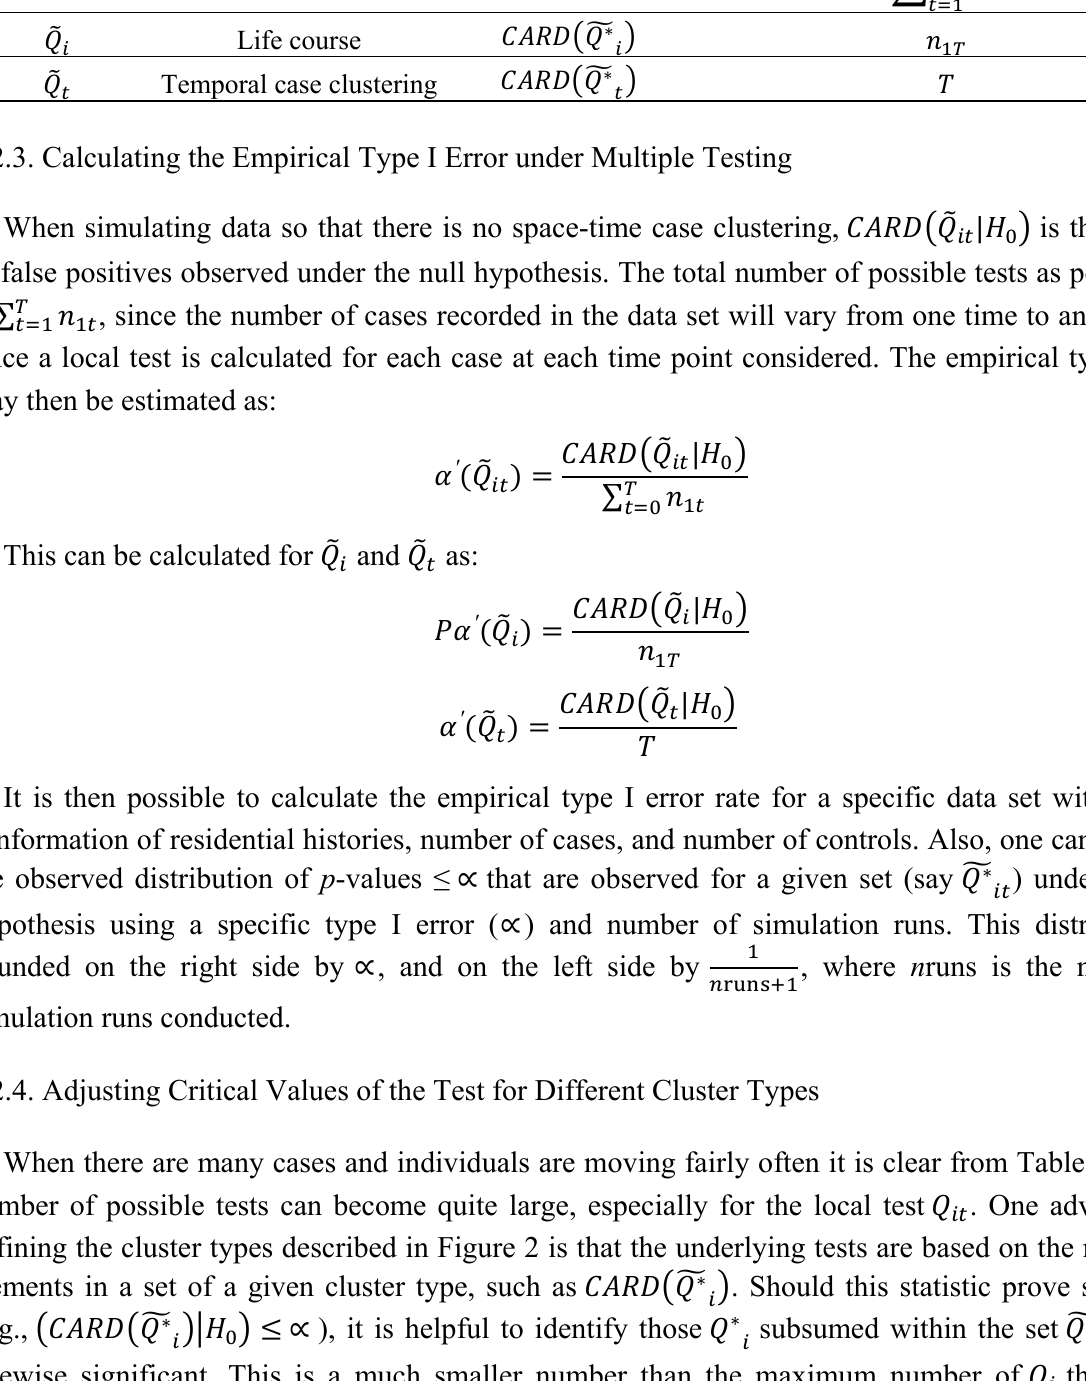
is the number of cases (cid:2869)(cid:3047)